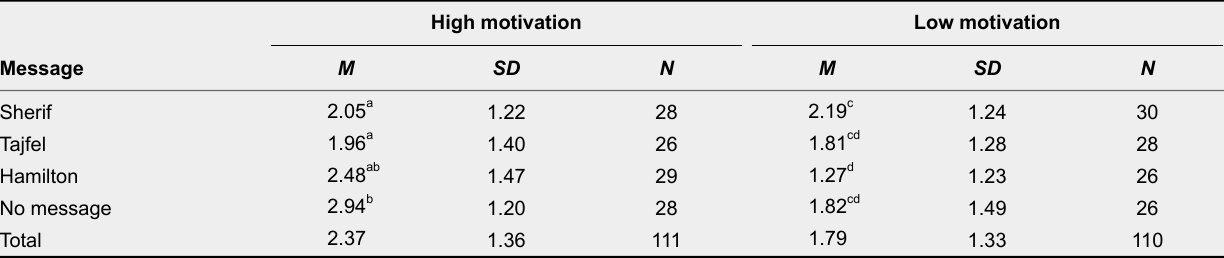
Ingroup Bias Against